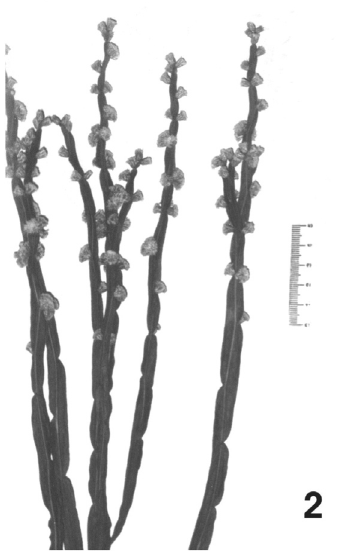
FIGURA 2 – Baccharis trimera (Less.) DC. – Ramos reprodutivos e vegetativos.